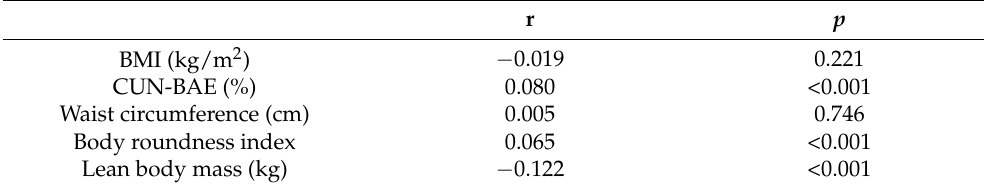
Table 3. Bivariate correlations of SAF with anthropometric formulas in the ILERVAS population.